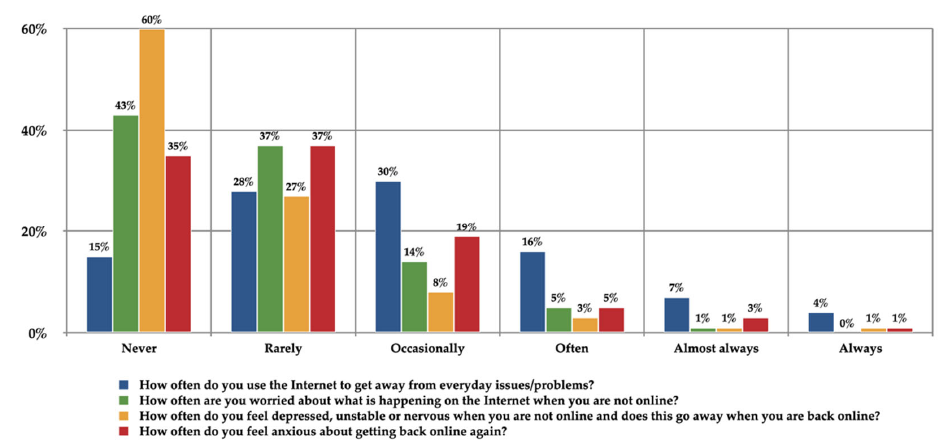
Figure 10. Attitudes towards not being online.